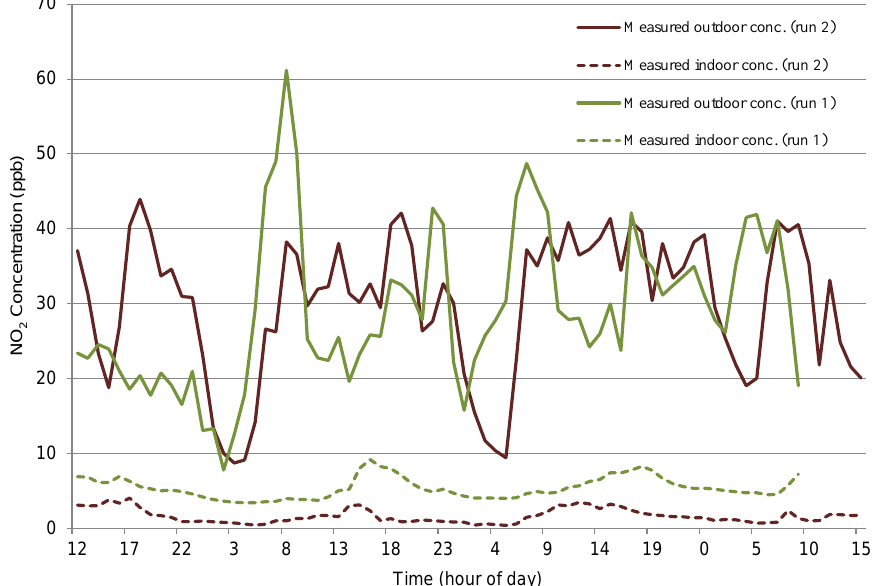
Figure 7. Measured indoor and outdoor NO 2 concentrations at N t 2 (run 1 and run 2).